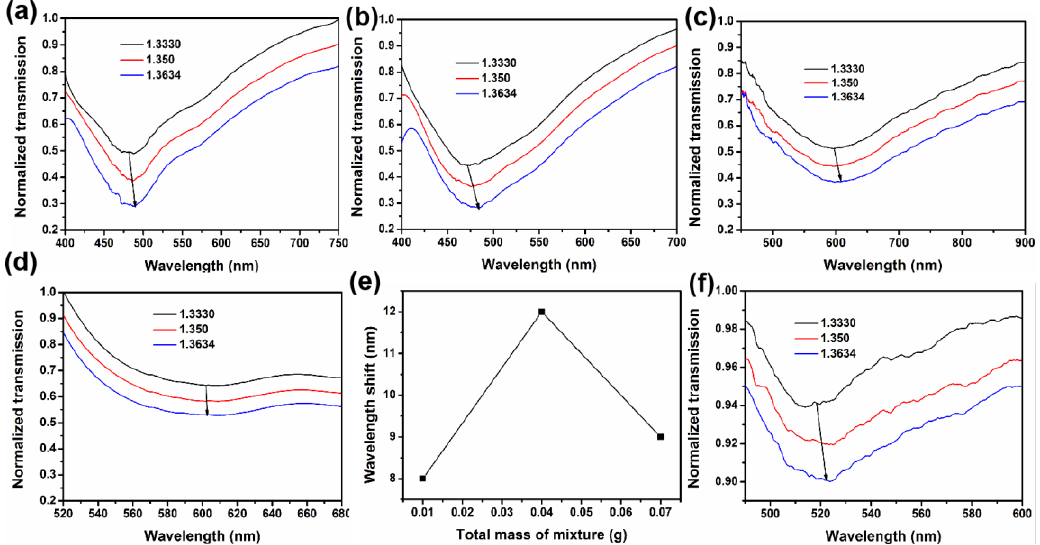
Figure 4. ( a – d ) Absorption spectra of ITO-NM/U-bent/0.01/20, ITO-NM/U-bent/0.04/20, ITO-NM/U-bent/0.07/20, and ITO-NM/U-bent/0.1/20 sensors in alcohol solution with RI from 1.3330 to 1.3634, respectively. ( e ) The broken line diagram of the shift of sensor at 20 cm with different growth conditions (reagents mixture: 0.01–0.07 g). ( f ) Absorption spectrum of U-bent with 3.1 nm Au film.